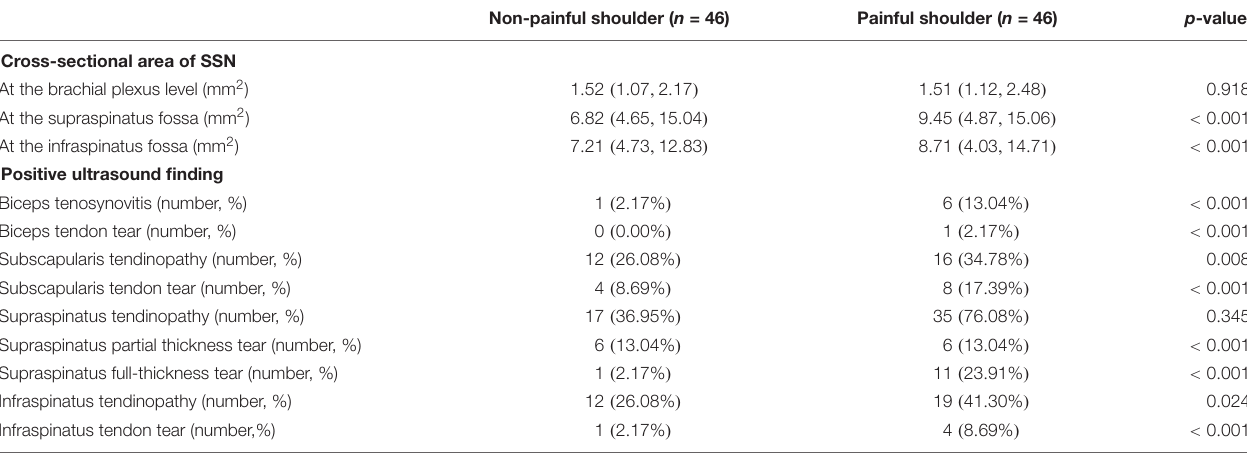
TABLE 2 | Suprascapular nerve (SSN) cross-sectional area measurements and ultrasound findings in subjects with unilateral involvement. Non-painful shoulder ( n = 46) Painful shoulder ( n = 46) p -value